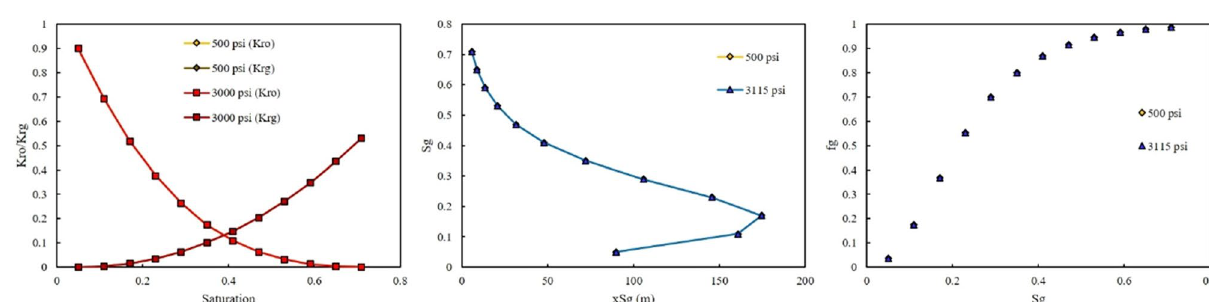
Figure 14. Effect of injection pressure of NGL on the ( a ) relative permeability, ( b ) saturation profile, and ( c ) fractional flow curve at GOR 2.5 MSCF/STB.